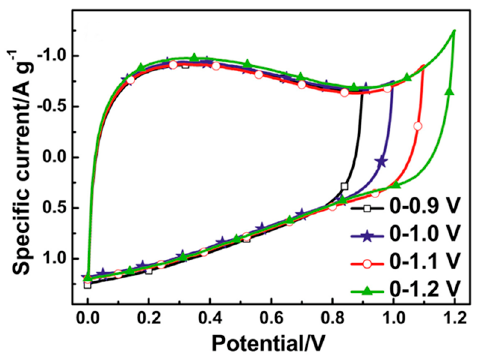
Figure 28. CV curves of the symmetric 2-electrode cell build with H 3 PO 4 activated carbon and charged to 0.9, 1.0, 1.1 and 1.2 V in 6 mol L − 1 KOH. Reproduced from [198] with permission from Elsevier © 2015.